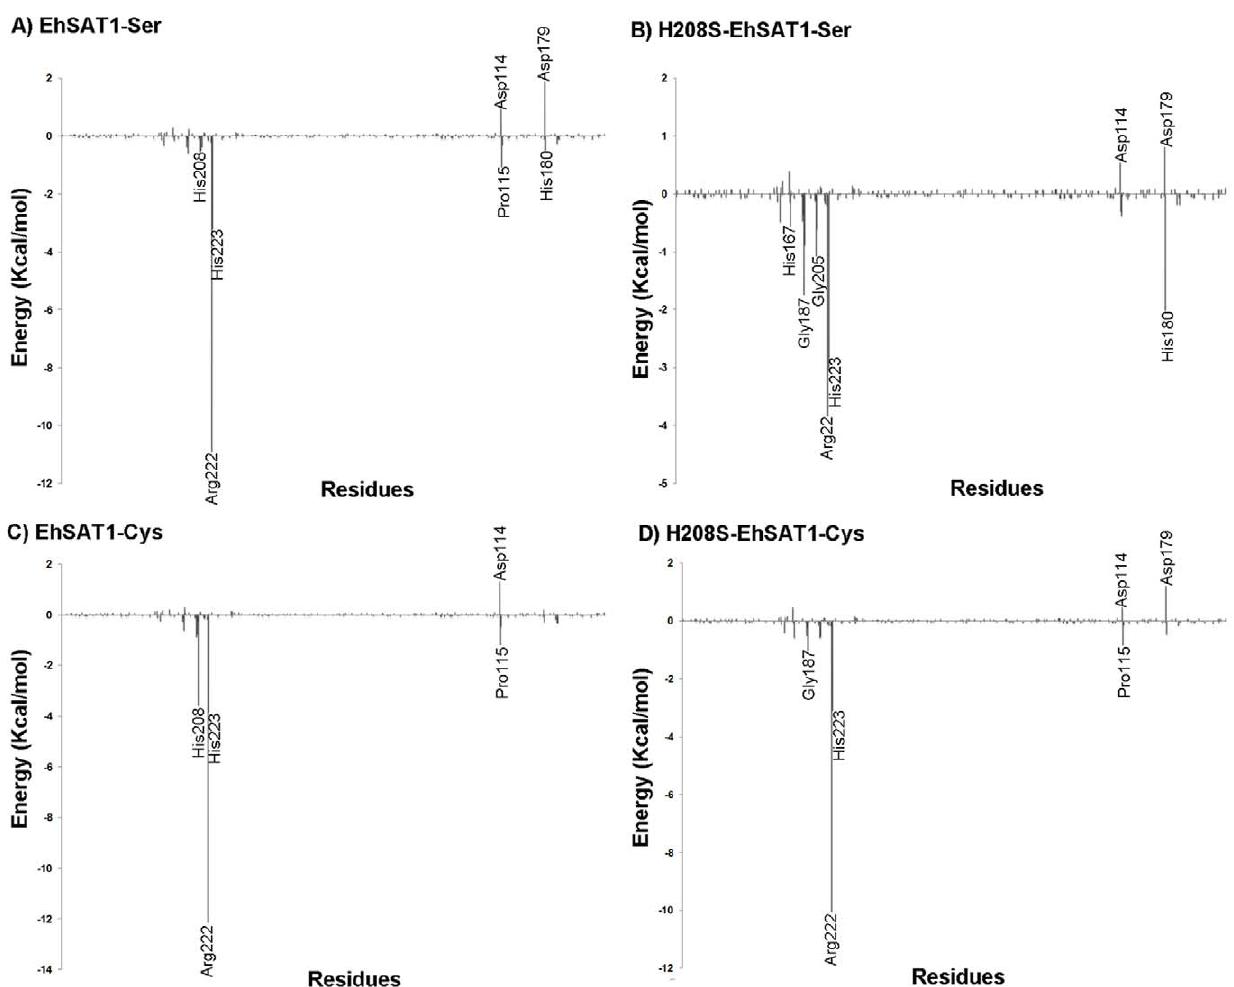
Figure 4. Per-residue energy contributions. The contribution of individual amino acid residues of EhSAT1 and H208S-EhSAT1 (which mimics the EhSAT3 active site) to the binding of serine and cysteine calculated using MM-GBSA method to find the important residues involved in specific binding shown in A) EhSAT1-Ser, B) H208S-EhSAT1-Ser, C) EhSAT1-Cys and D) H208S-EhSAT1-Cys. Arg 222 and His 223 provide the strongest contributions in all of the complexes, although the strength of the contributions decreases for the mutants. Strikingly, His208 contributes to binding affinity only for the EhSAT1-Cys complex structure, where it is the third strongest contributor. This contribution is not seen in EhSAT1-Ser or any of the mutant structures.